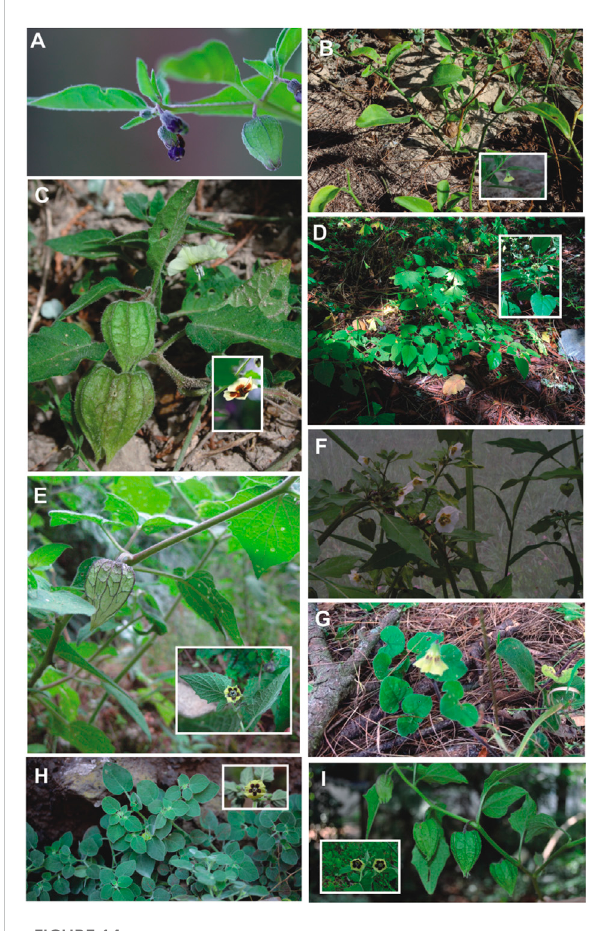
Detailsof fl owersandfruitsof Physalis spp. (A) P.solanacea , (B) P. spathulifolia , (C) P. sordida , (D) P. subrepens , (E) P. tamayoi , (F) P. sulphurea , (G) P. volubilis , (H) P. vestita , (I) P.